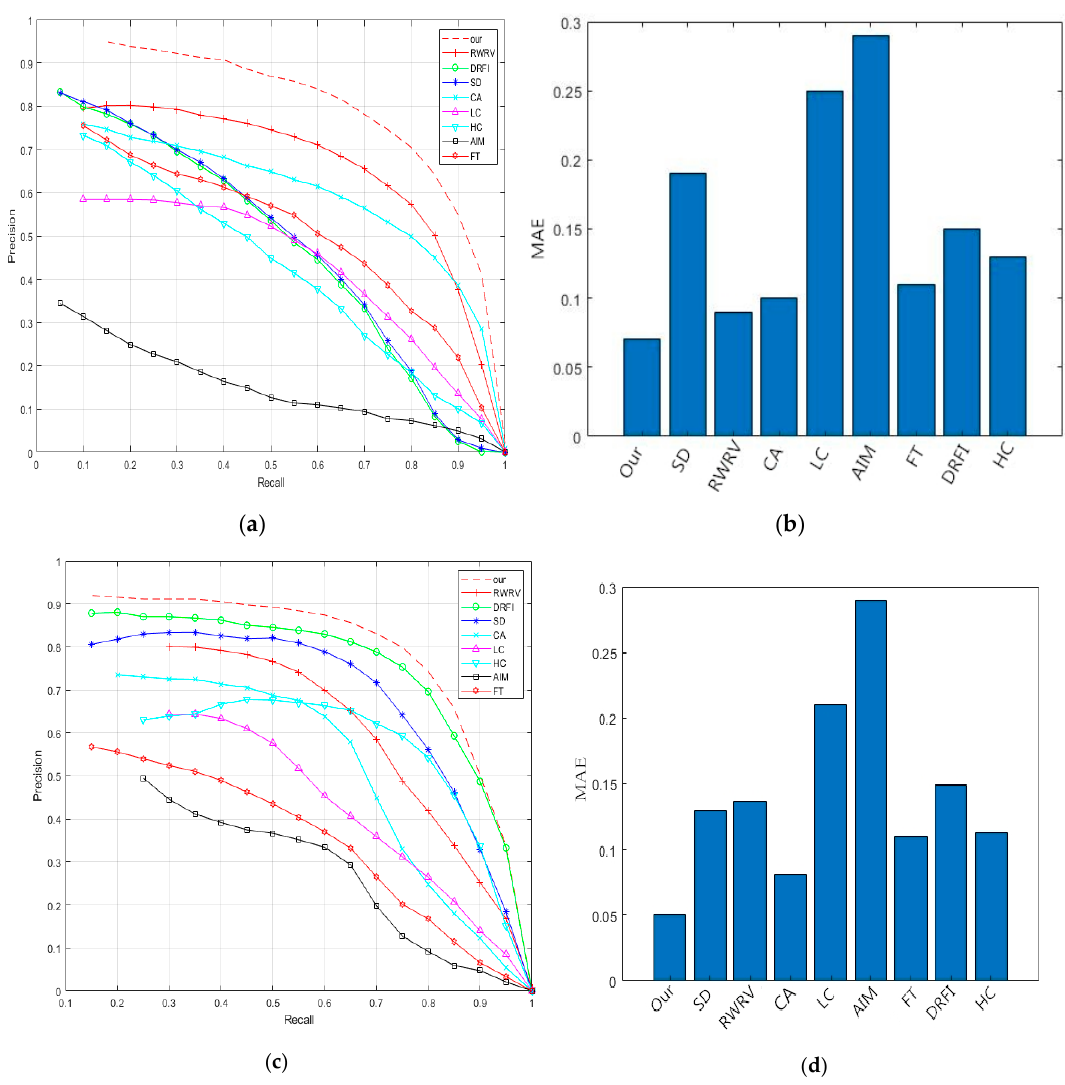
Figure 6. Precision–recall (PR) curves and mean absolute errors (MAEs) for the two datasets generated